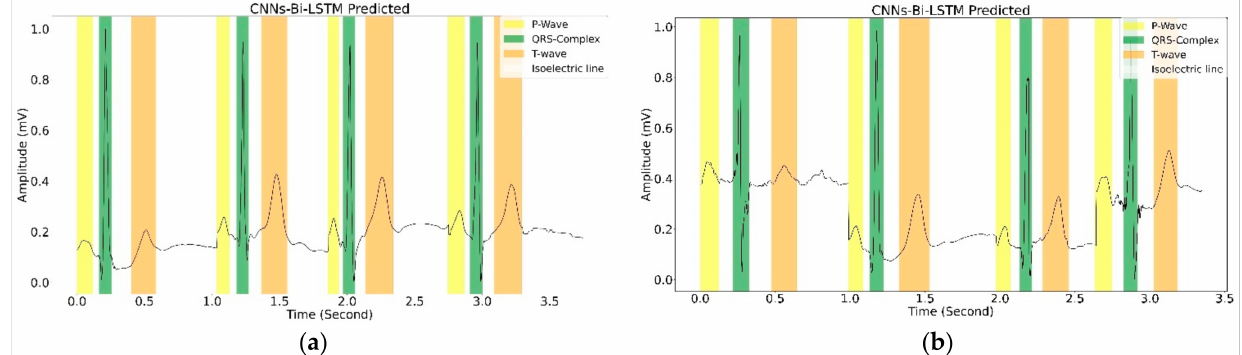
Figure 9. The four-beat sample of ECG-signal delineation in ( a ) NSR and ( b ) arrhythmia.